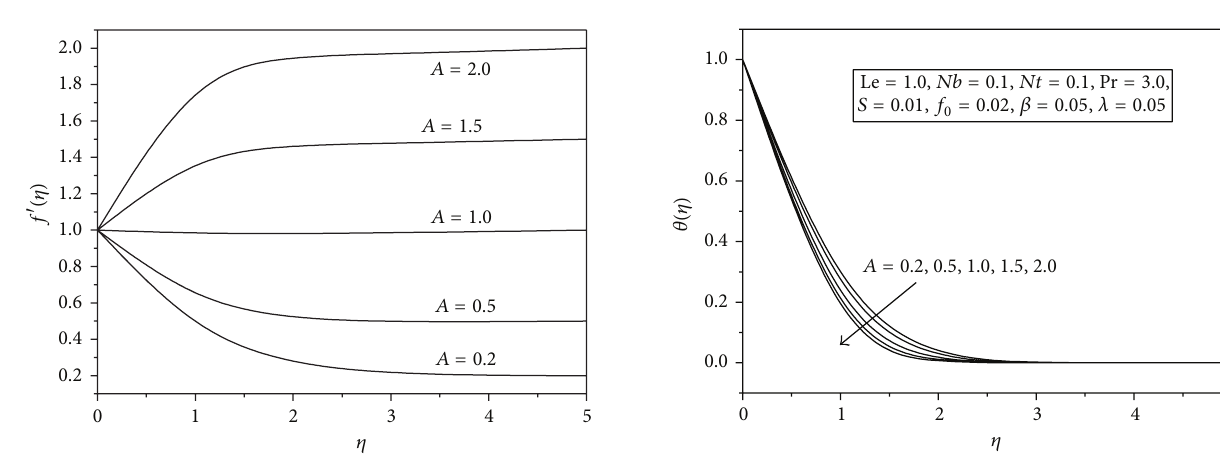
Figure 2: Velocity profile for different values of 𝐴 . Figure 3: Temperature profile for different values of 𝐴 .